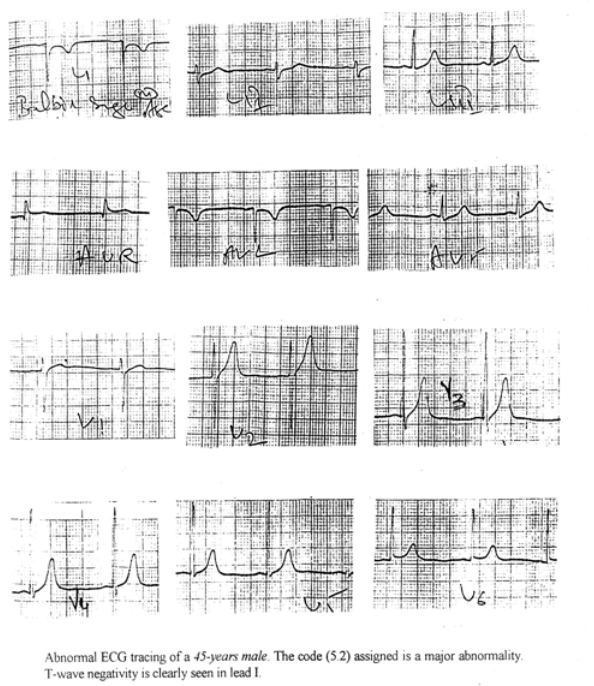
Figure 4b : An abnormal ECG tracing from the study sample